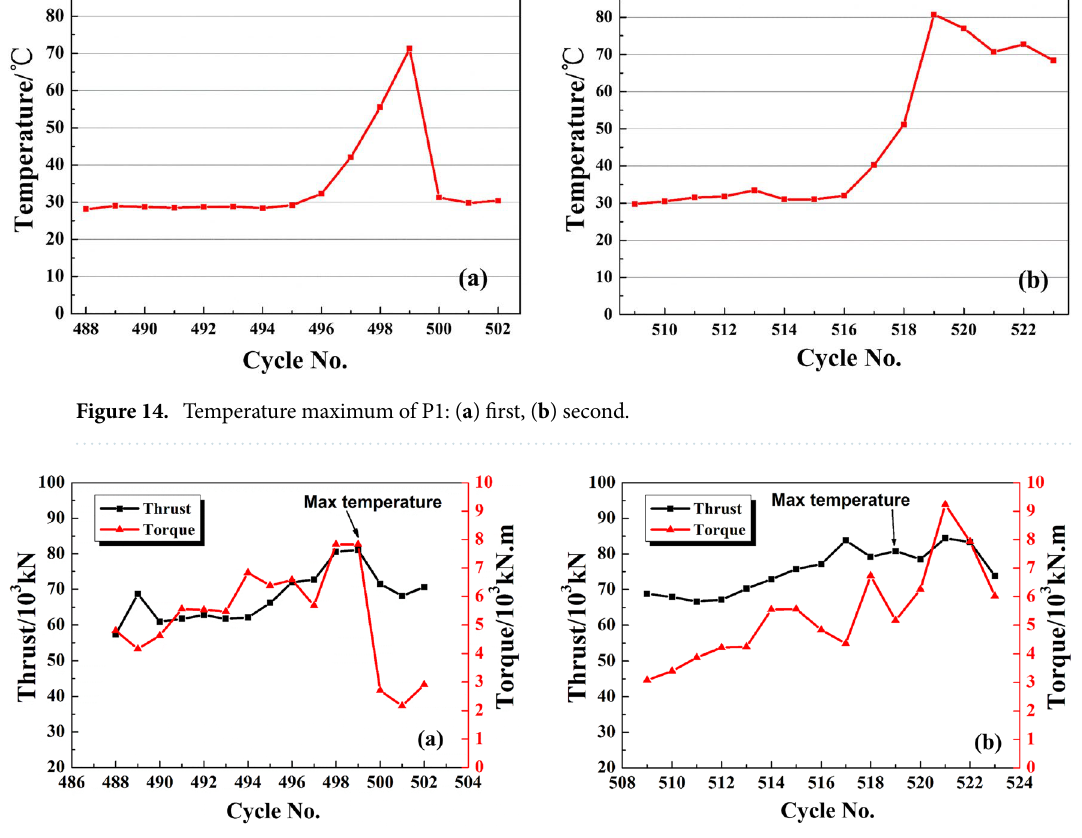
Figure 15. Average thrust and torque: ( a ) first, ( b )